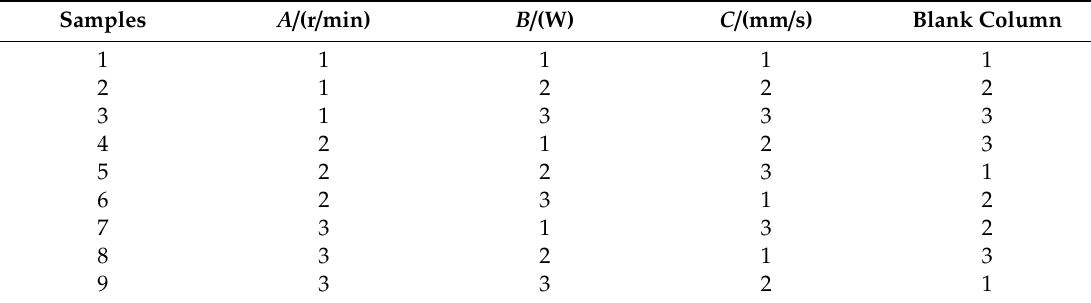
Table 4. Orthogonal experiment scheme. Table 3. Level and factor design of orthogonal experiment.